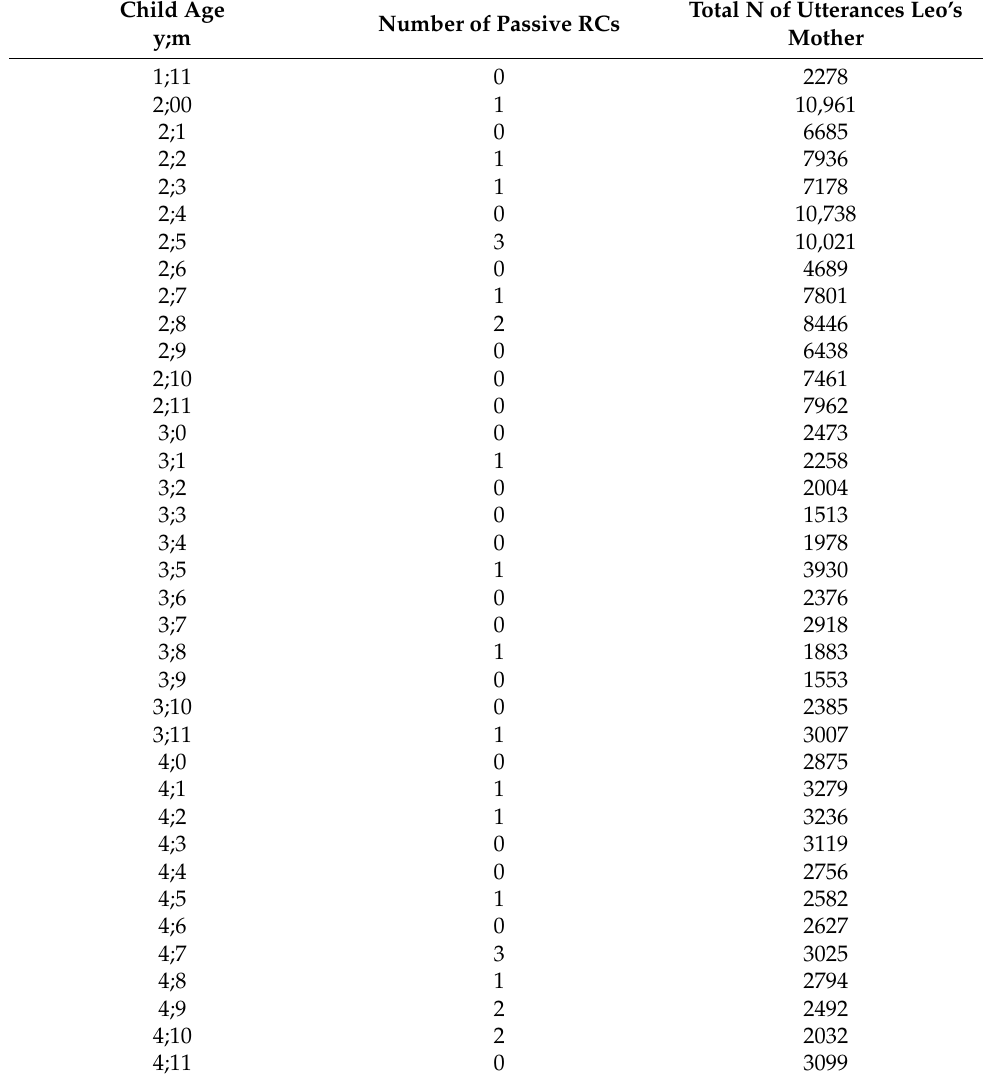
Table A2. Number of passive RCs compared to the total of utterances produced by Leo’s